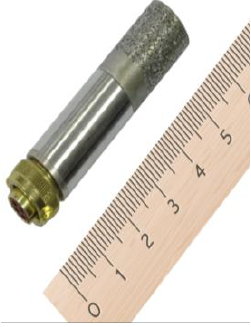
Figure 1. The transducer with sensor for test